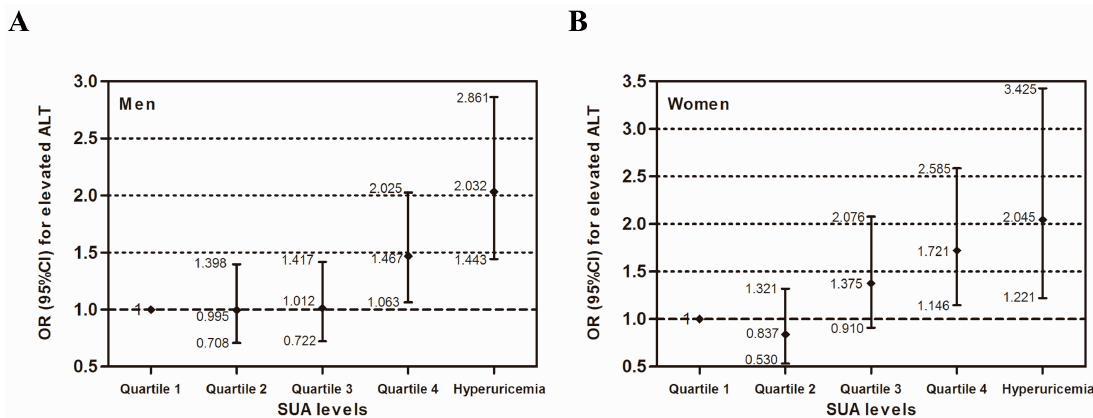
Figure 2. Multivariate analysis of the independent association between serum uric acid and elevated serum ALT by gender ( A ) for men and ( B ) for women. The model is adjusted for the same variables as in model 2 in Table 3.